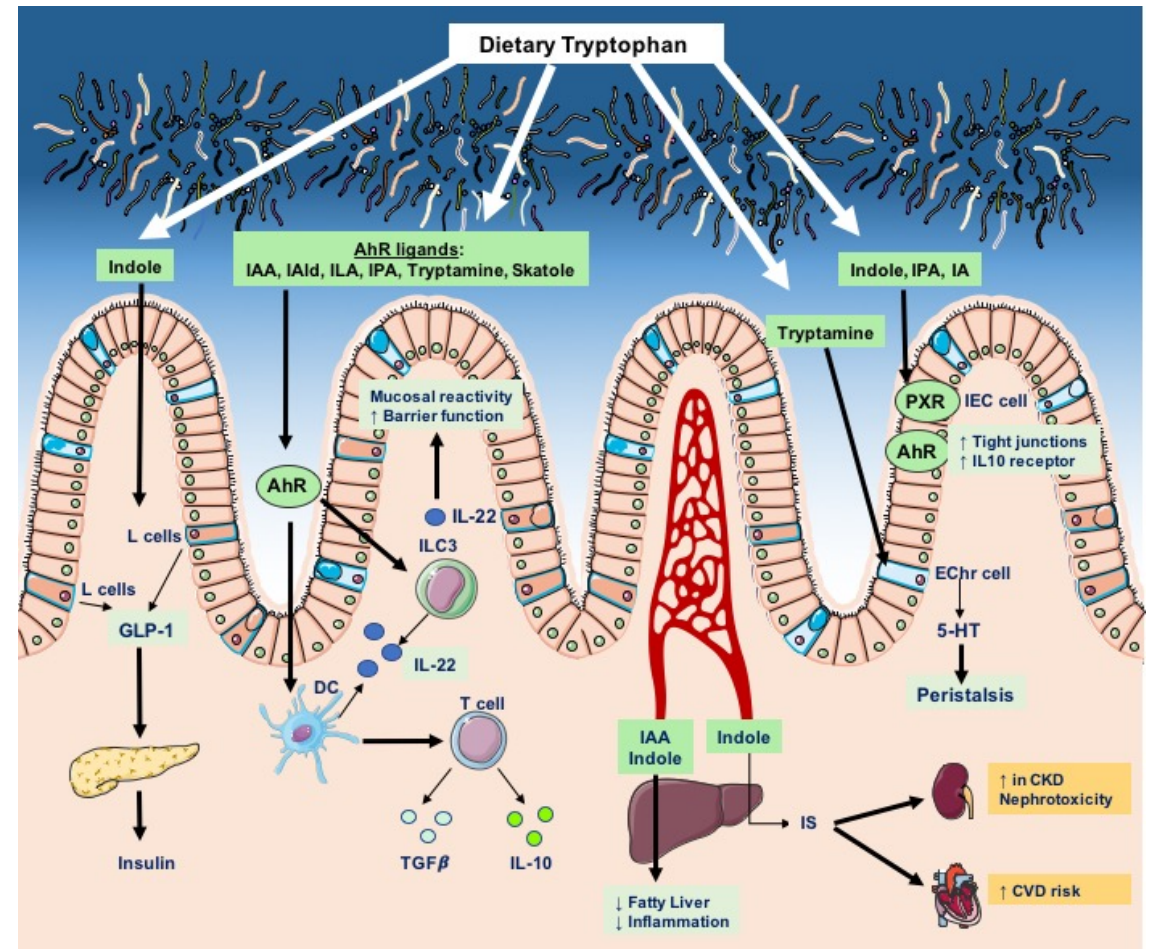
Figure 3. Microbiota-derived tryptophan metabolites modulate various host physiological processes. From left to right: indole signals to enteroendocrine L cells to induce the secretion of GLP-1, which stimulates insulin secretion by pancreatic beta cells. Many of the bacterial tryptophan catabolites—such as indole acetic acid (IAA), indole-3-acetaldehyde, indole-3-aldehyde (IAld), indole-3-lactic acid (ILA), indole-3-propionic acid (IPA), tryptamine, and skatole—activate the aryl hydrocarbon receptor (AhR) in intestinal immune cells; AhR activation in dendritic cells (DC) and type 3 innate lymphoid cells (ILC3) promotes production of IL-22—a central cytokine for intestinal